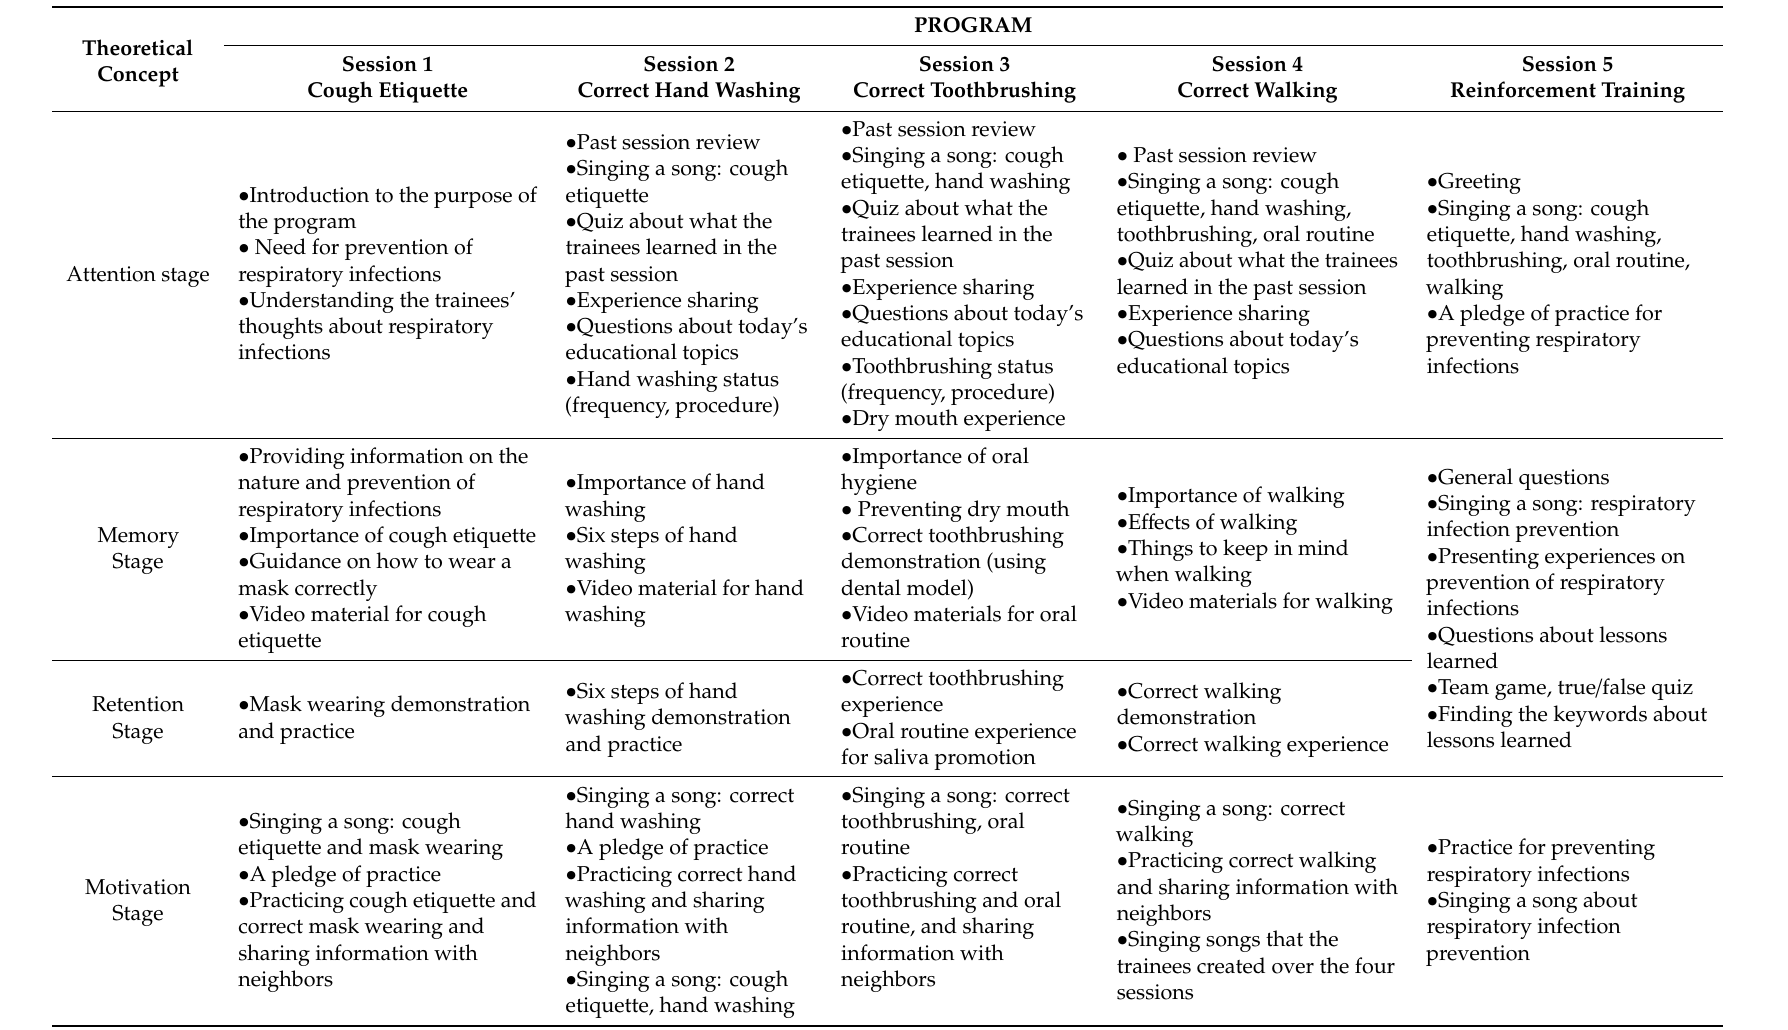
Table 2. Contents of the